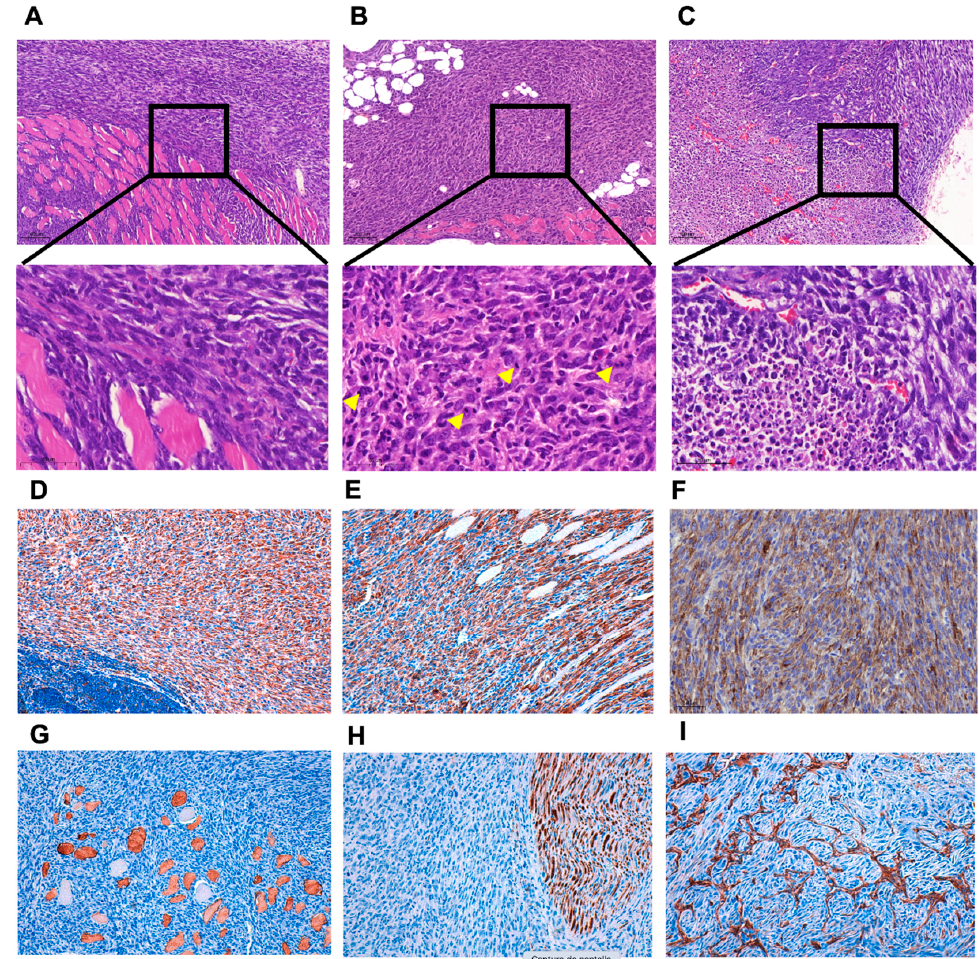
Figure 1. Histological and immunohistochemical characterization of 3MC-induced tumors . Rep- resentative hematoxylin and eosin-stained fixed sections of tumors induced by 3MC. ( A ) At low magnification (10×), the tumors show high cellular density and infiltrated local muscle fibers. ( B ) At high magnification (40×), the cells display spindle or epithelial morphology, nuclear atypia, and frequent mitosis (indicated by yellow arrows). ( C ) There are large areas of necrotic cells located at the center of the tumor. Original magnification is 10×; insets are shown at a 40× magnification. Rep- resentative images of immunohistochemical staining in fixed section of tumors induced by 3MC. The tumor cells were positive for vimentin ( D ), smooth muscle actin ( E ), and caldesmon ( F ). Desmin ( G ), protein S100 ( H ), and CD34 ( I ) were negative. Pictures are shown at a 20× magnification.